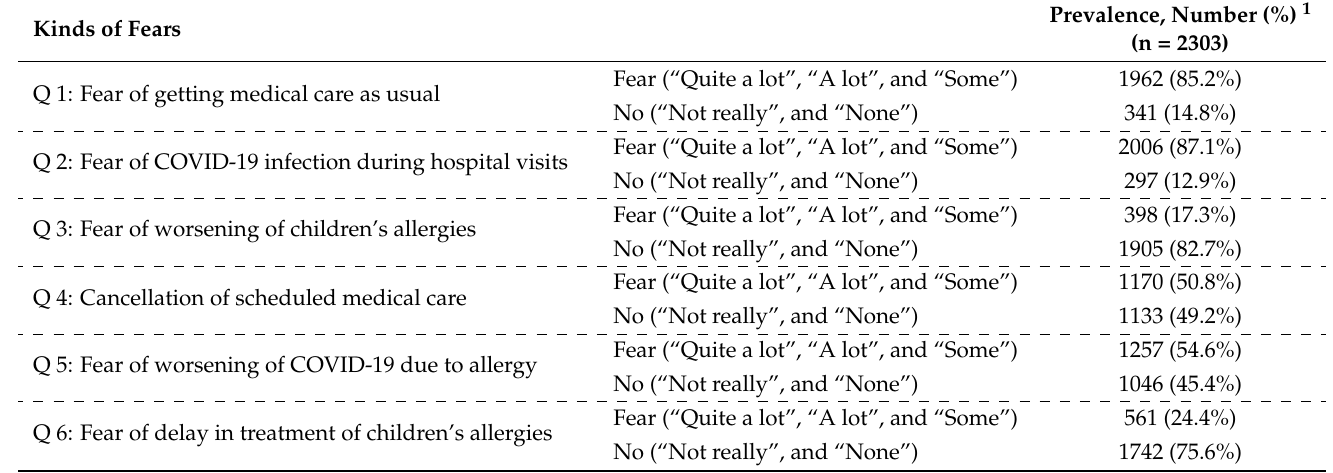
Table 2. Prevalence of fears among 2302